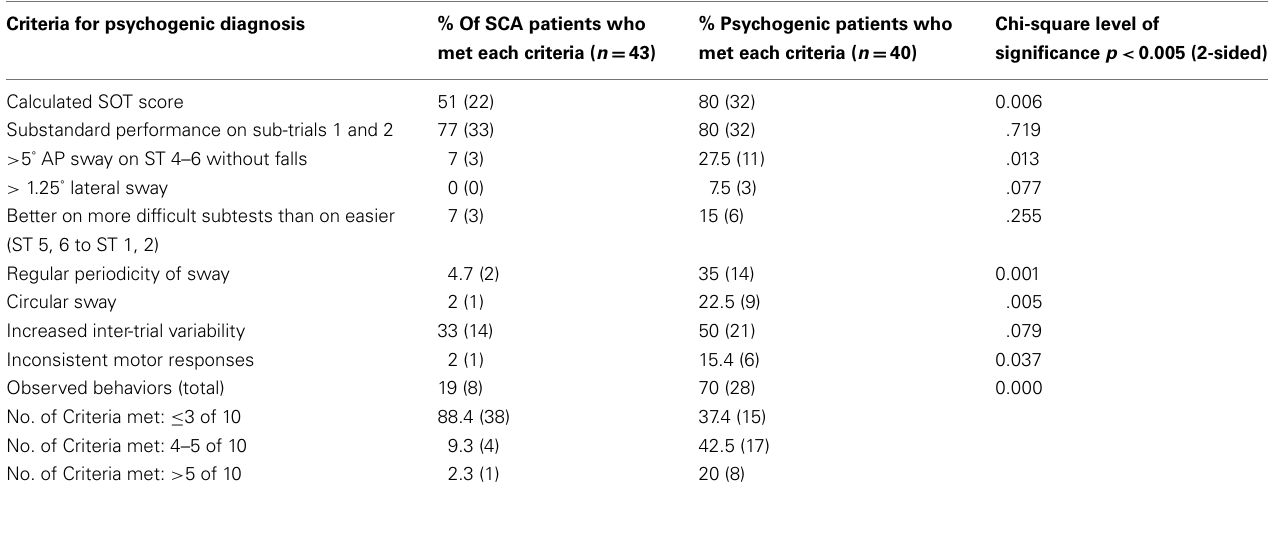
Table 3 | Frequency distribution of CDP criteria in patients with SCA and in patients with psychogenic problems. Criteria for psychogenic